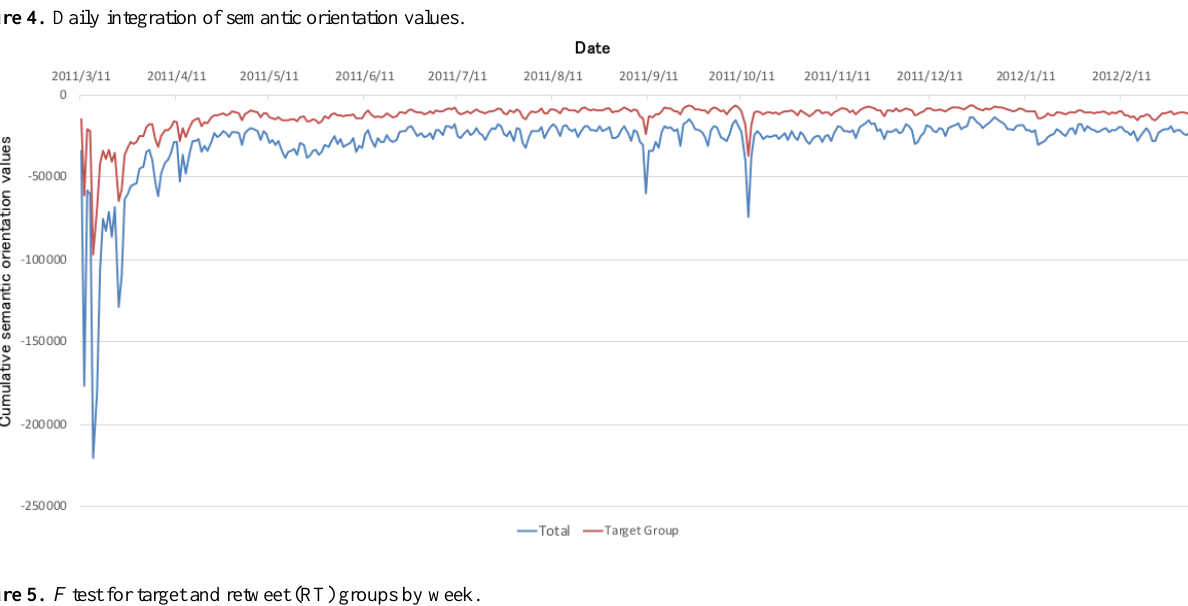
Figure 4. Daily integration of semantic orientation values.